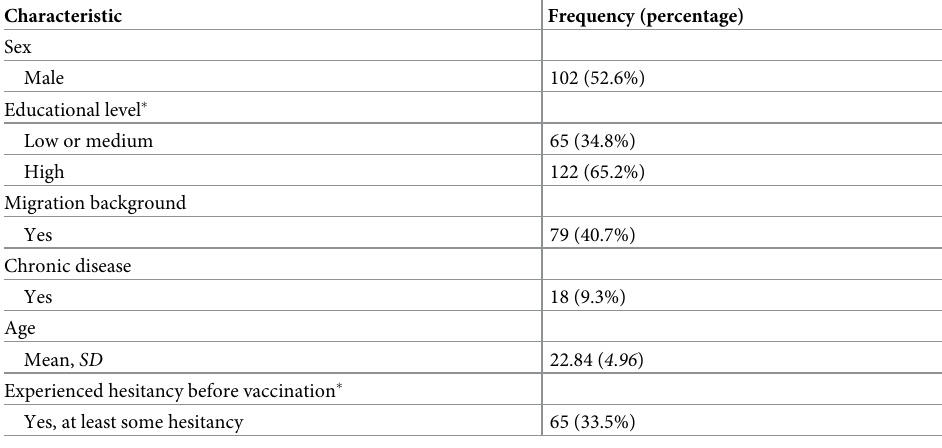
Table 1. Background characteristics of the complete sample (N =